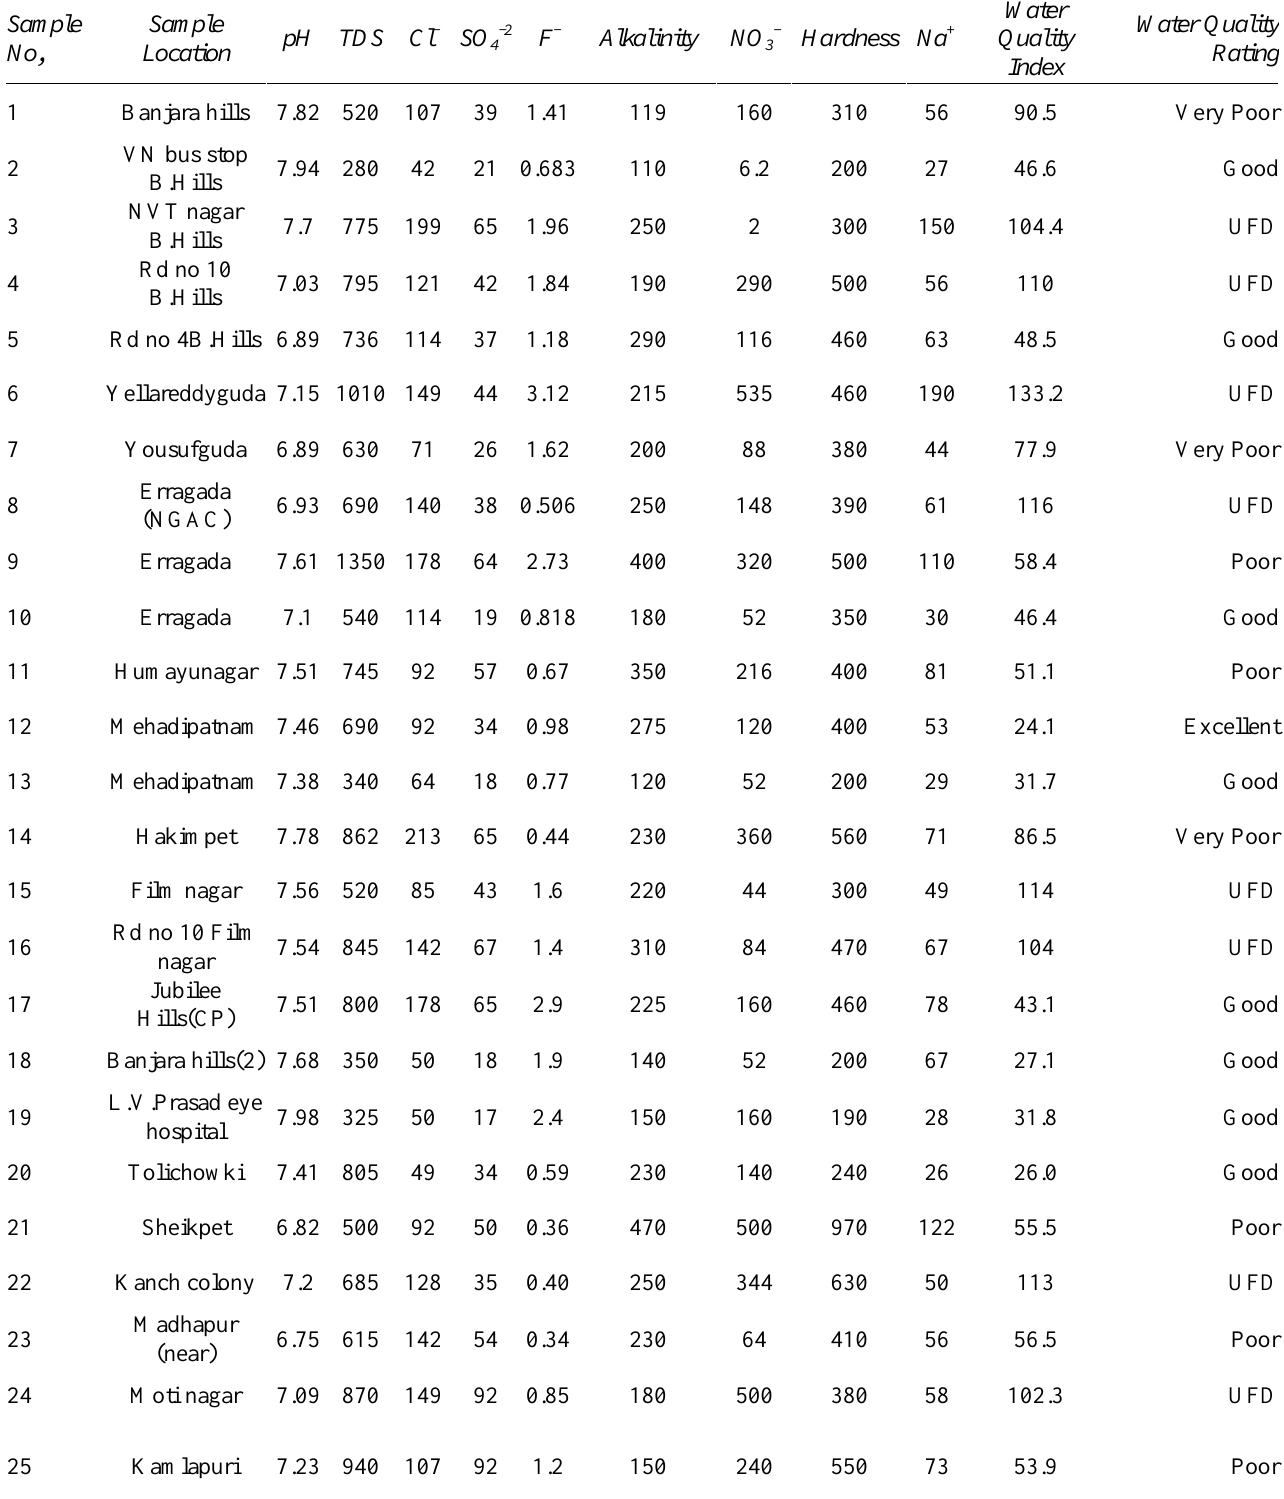
All units except pH and Water quality index are in mg/l